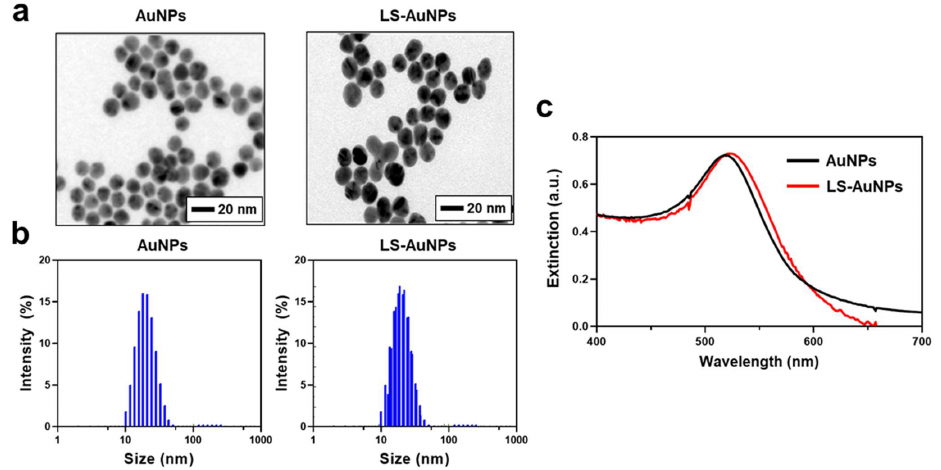
Figure 3. ( a ) Transmission electron microscopy (TEM) images of as-synthesized AuNPs and LS-AuNPs. ( b ) Size distribution of AuNPs and LS-AuNPs, as measured by dynamic light scattering (DLS). ( c ) UV/Vis extinction spectra of AuNPs and LS-AuNPs. Table 1. Hydrodynamic diameters and zeta potentials of the AuNPs and LS-AuNPs ( n = 3, mean ± SD) .